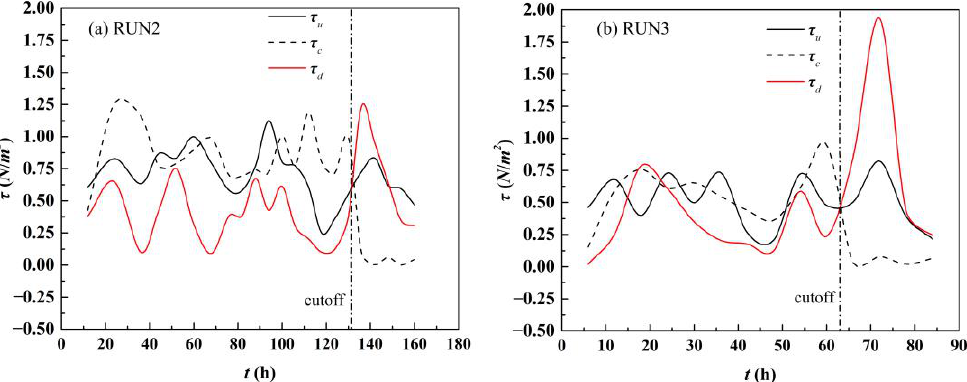
Figure 11. Variations in three average shear stresses during ( a ) RUN2 and ( b ) RUN3. When cutoff occurred, τ c was the highest and τ d was the lowest. After cutoff, τ c sharply decreased, while both τ u and τ d increased.